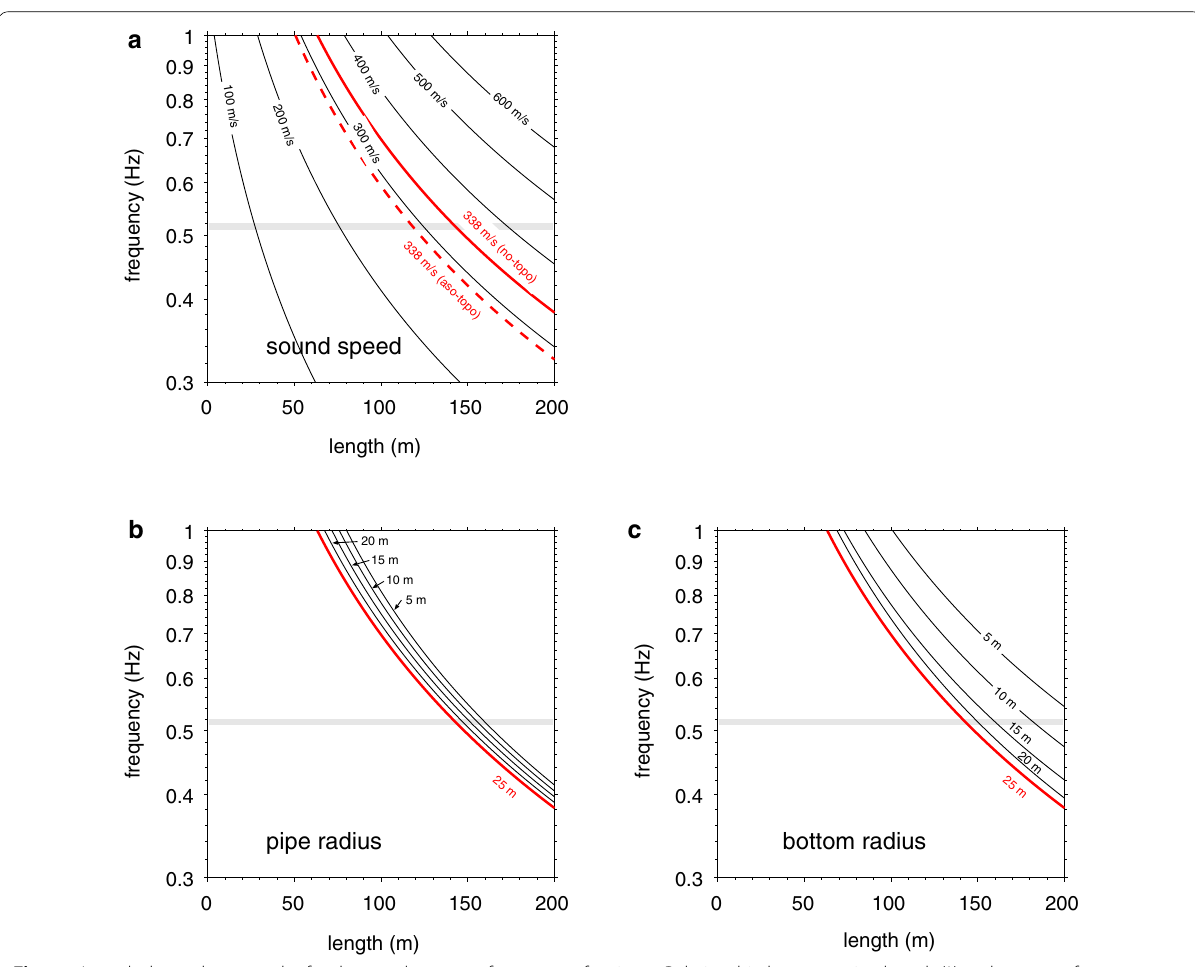
Fig. 11 Length dependence on the fundamental resonant frequency of a pipe. a Relationship between pipe length ( L ) and resonant frequency ( f 0 ) with variable sound speed inside the pipe ( c air ; 100–600 m/s) calculated using Eq. (3) with a fixed radius of the pipe ( a = 25m ). Red solid and dashed lines show the velocity of 338 m/s used in our FDTD calculations (without and with topographic data, respectively). The peak frequency of the observed infrasound records is shown by a gray horizontal bar (0.51–0.52 Hz at 22:23:00–22:23:10 on March 25, 2015). b Dependency of variable size of pipe radius ( a ). The red line is the same as that in a : a = 25m , c air = 338m/s , and without topographic conditions. c Effect of pipe geometry from a simple straight pipe to a conical pipe. The bottom radius of the pipe changes from 25 m (red line) to 5 m, whereas the radius of the other side (top portion) is fixed at 25 m ( a